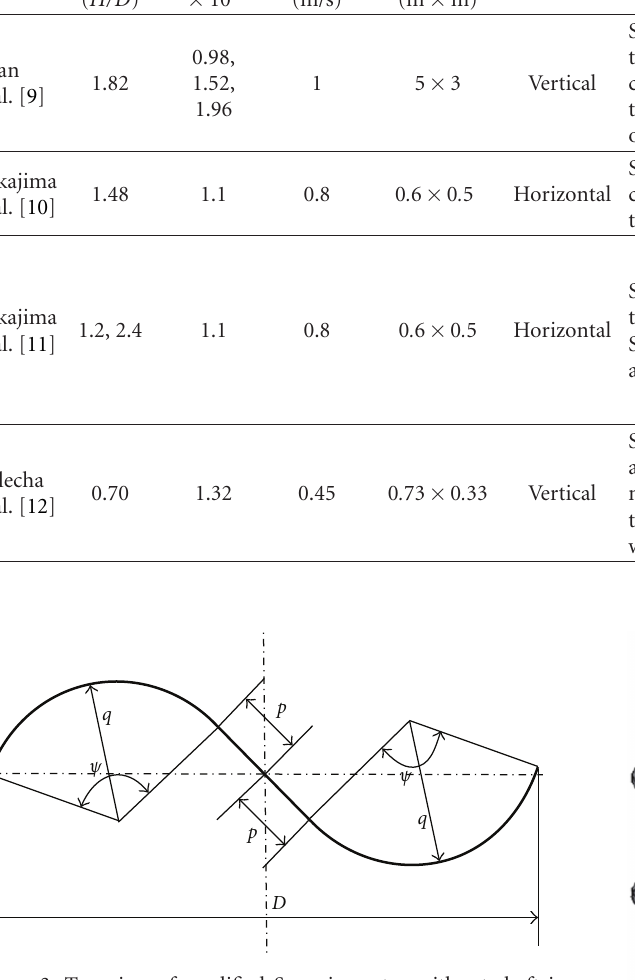
Figure 3: Top view of modified Savonius rotor without shaft in between the end plates [18].